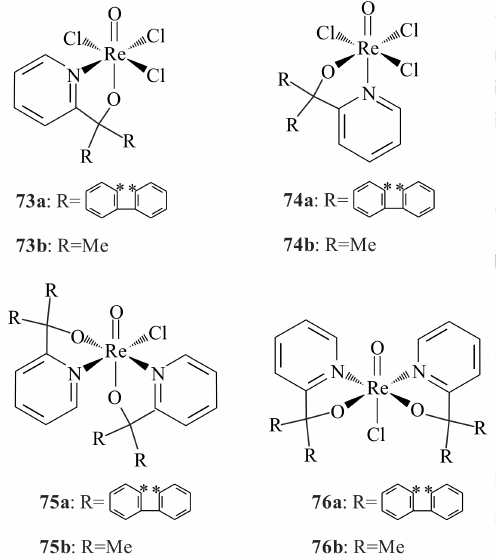
Figure 14. Pyridinyl alcoholato complexes of